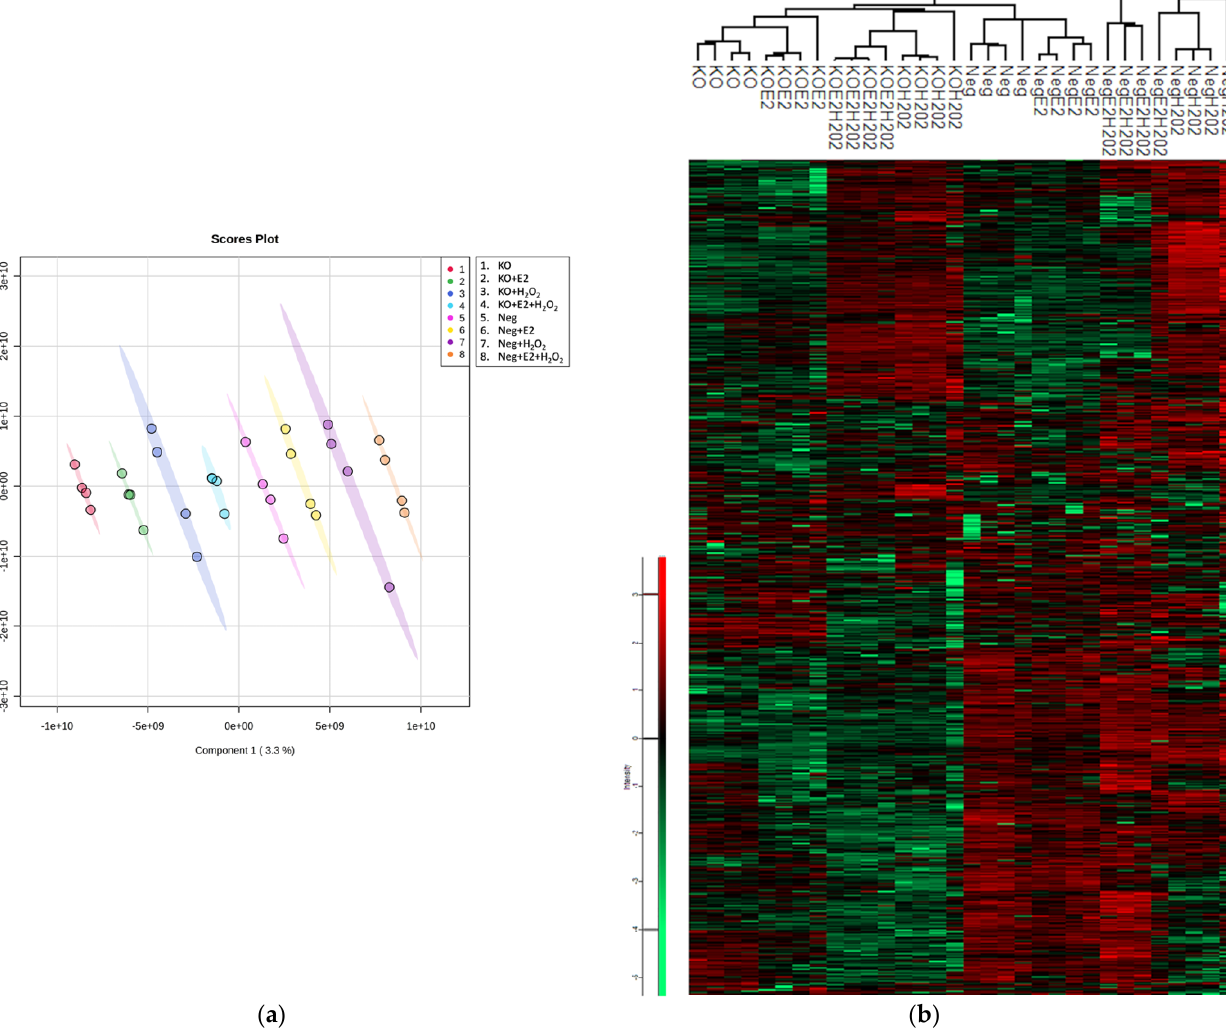
Figure 1. Statistical separation of the analyzed groups and distribution of the quantitative data. ( a ) PLS-DA was performed, showing good separation between the eight experimental groups. Each experimental group is labeled with a numbered class color and each number corresponds to a specific group. ( b ) The heatmap was generated to visualize the distribution of protein abundances throughout the replicates using adjusted data based on Z-score normalization. The green and red color ranges refer to the lower and higher abundances, respectively. Table 1. Qualitative results of the differentially regulated proteomes after the comparative